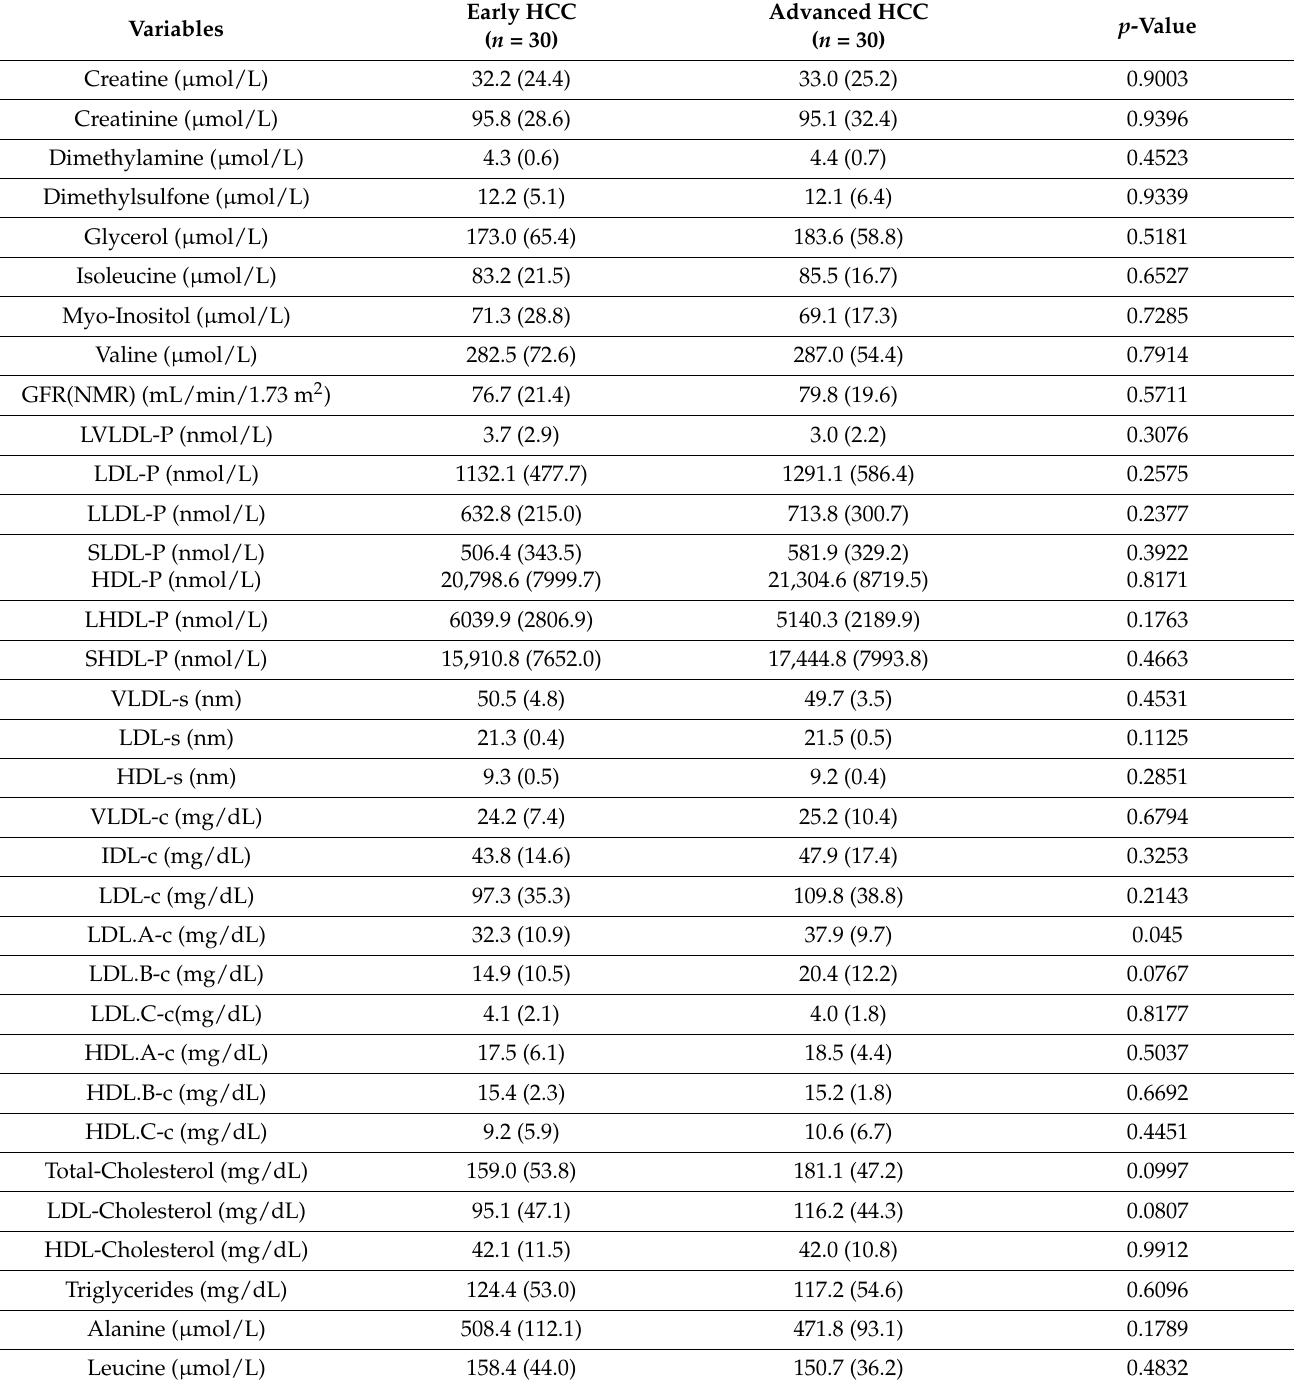
Table 4. Serum concentration levels of the metabolite and lipid parameters that were analyzed in the present study using the standardized AXINON ® platform (Numares AG, Regensburg, Germany). The mean values and standard deviations (SD, in parentheses) as well as p -values are